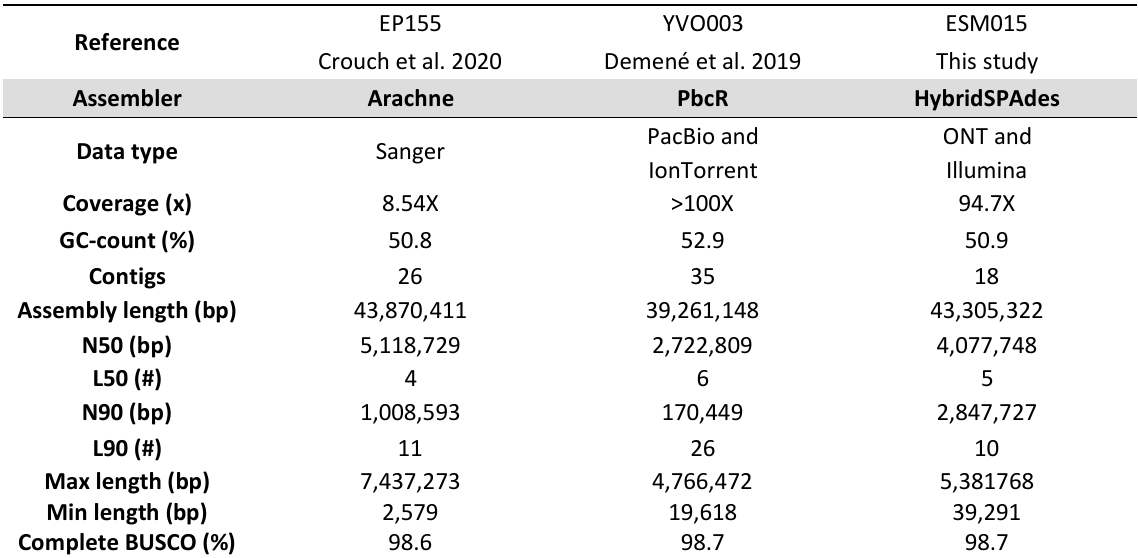
Table 1 . Assembly statistics for the genomes of the Cryphonectria parasitica isolates EP155,